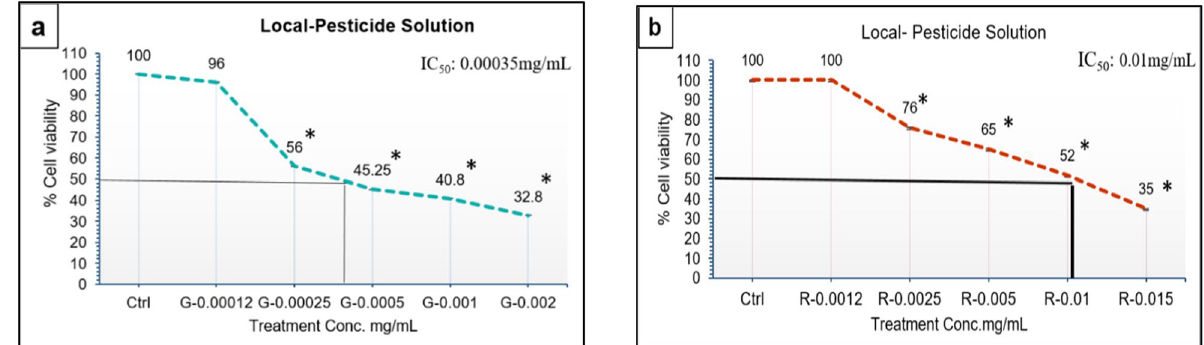
Figure 1. Mean cell viability of NIH 3T3 cells after 24 h exposure at different specific concentrations of Local consumer pesticide solution in mg/mL. ( a) Green solution (local pesticide) specific dose treatments. ( b) Red solution (local pesticide) specific dose treatments . ANOVA and LSD post-hoc analyses were used to compare means of the treated cells with untreated control cells. Data were presented as Standard Error of Mean (Mean ± SEM) of triplicate determinations. The mean difference is significant when * p < 0.001. Ctrl: control, G: green local pesticide solution; R: red local pesticide solution; IC50: maximum half inhibitory concentration (mg/